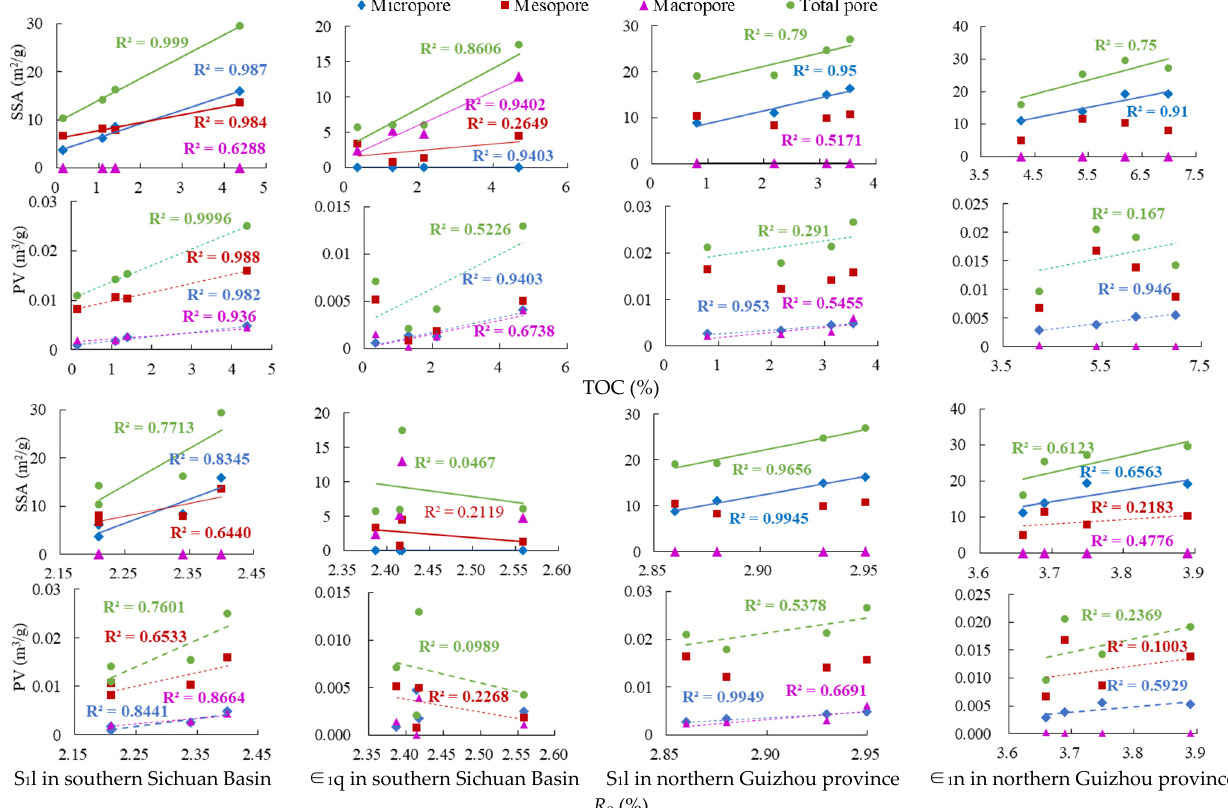
Figure 15. Relationship between TOC, R o and pore structure parameters of the Lower Paleozoic shale from the upper Yangtze plate.